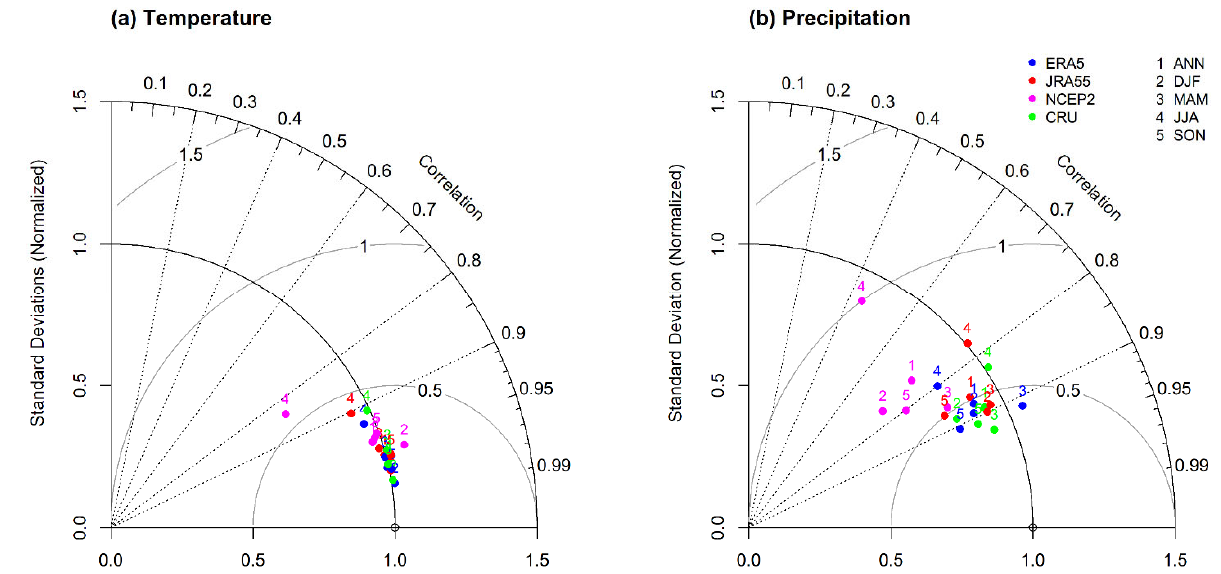
Figure 9. Taylor diagrams of ( a ) temperature and ( b ) precipitation from ERA5, JRA55, NCEP2, and CRU data, compared to observations, in the EAM region using the annual and seasonal averages over the forty years of 1981–2020 for North Korea, South Korea, and Japan and the thirty years of 1981–2010 for China.